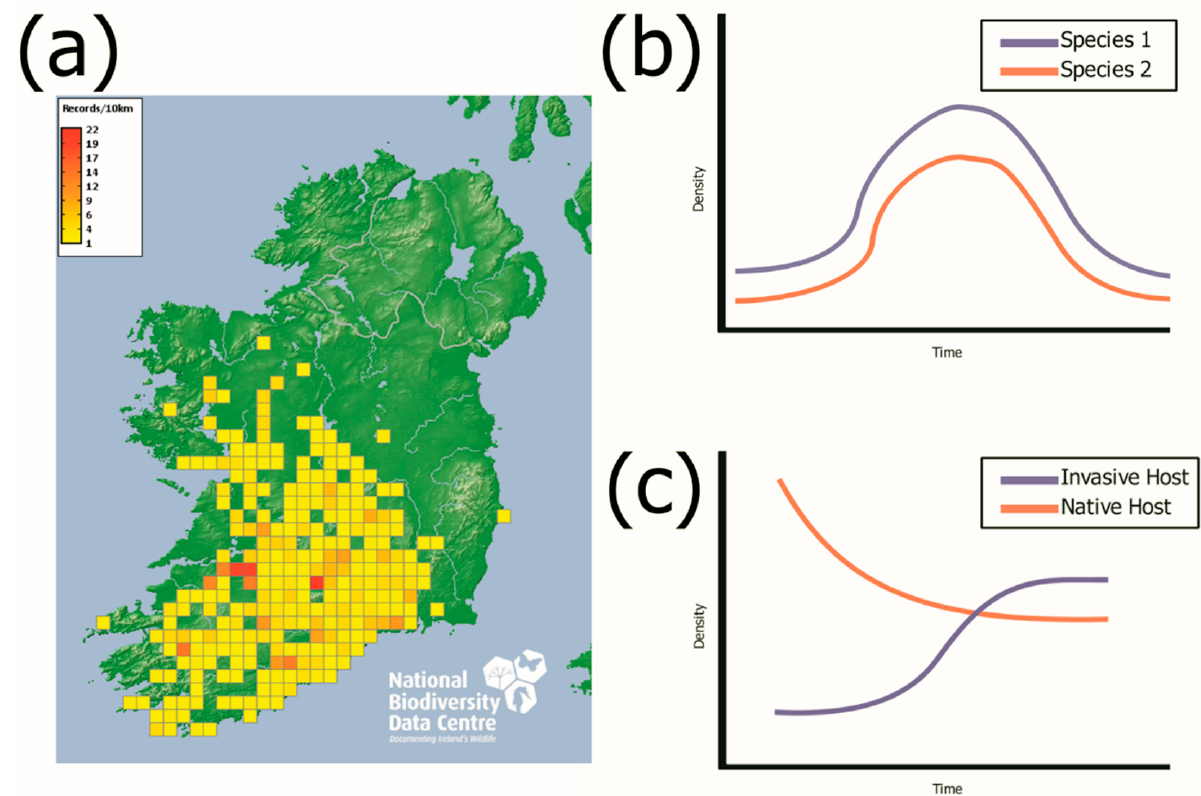
Figure 2. Current range of the bank vole ( M. glareolus ) and hypothetical population dynamics at core and expansion front sites. Part ( a ) shows the current distribution of the M. glareolus in Ireland. Part ( b ) provides an illustration of the multi-annual population cycle of two host species. Part ( c ) provides an illustration of the population dynamics of two host species when the population of the native host species declines as the population of the invasive host species increases. Part ( a ) taken with permission from the National Biodiversity Data Centre, Ireland [92].